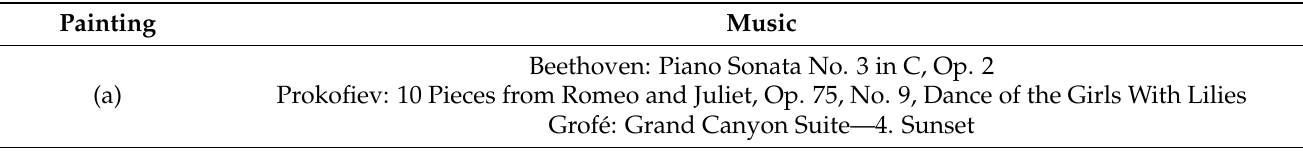
Table 5. Music–painting matching scheme. The top three pieces of music selected by our system for each painting are shown. Rows 1, 2, and 3 correspond to musical choices 1, 2, and 3,